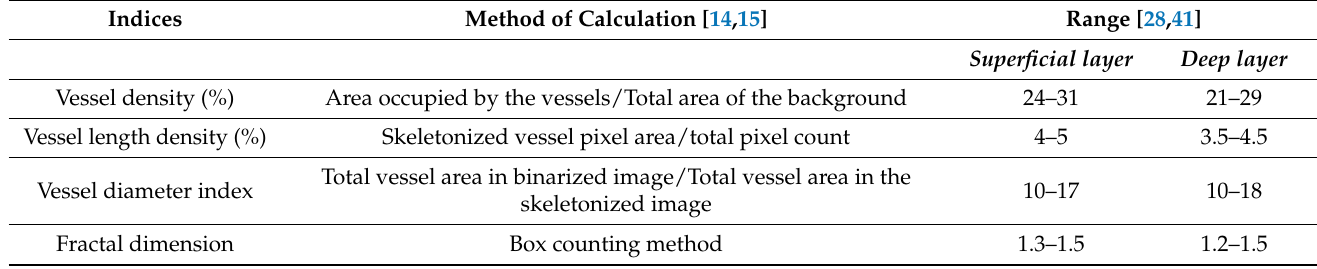
Figure 5. ( A – L ) Slit lamp photographs captured without and with fluorescein staining along with infrared and anterior segment optical coherence tomography angiography (AS-OCTA) images in an eye with acute chemical burns. An inferior corneal and conjunctival epithelial defect is present at the first visit ( A , B ). Healing of the corneal defect is observed within one week ( E , F ) while the conjunctival defect takes two weeks for the same ( I , J ). ( C , G , K ) Sub-conjunctival hemorrhages are clearly delineated on the infrared image taken on day 1 (yellow arrowhead) and its resolution is noted in the subsequent visits. ( D , H , L ) AS-OCTA image taken at presentation depicts partial lack of vascular signal which gradually recovers over the subsequent follow-up visits. Table 1. Summary of various vessel-related parameters used for quantifying limbal vasculature and their reported